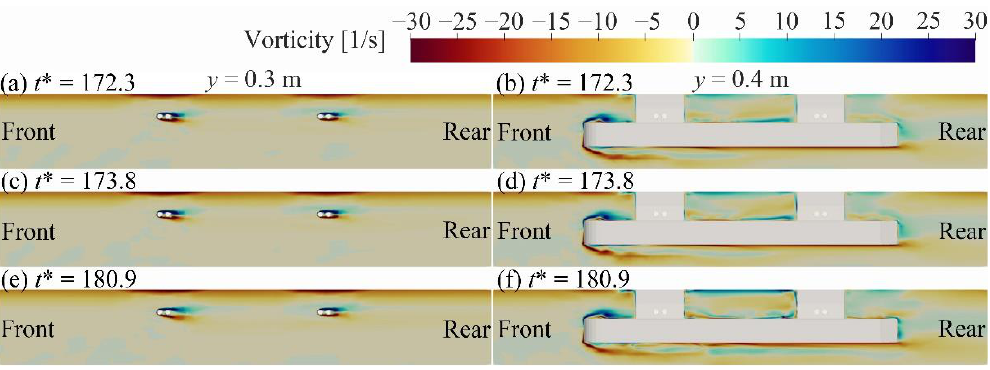
Figure 11. Vorticity around the platform at y = 0.3 m and y = 0.4 m for Case A2.